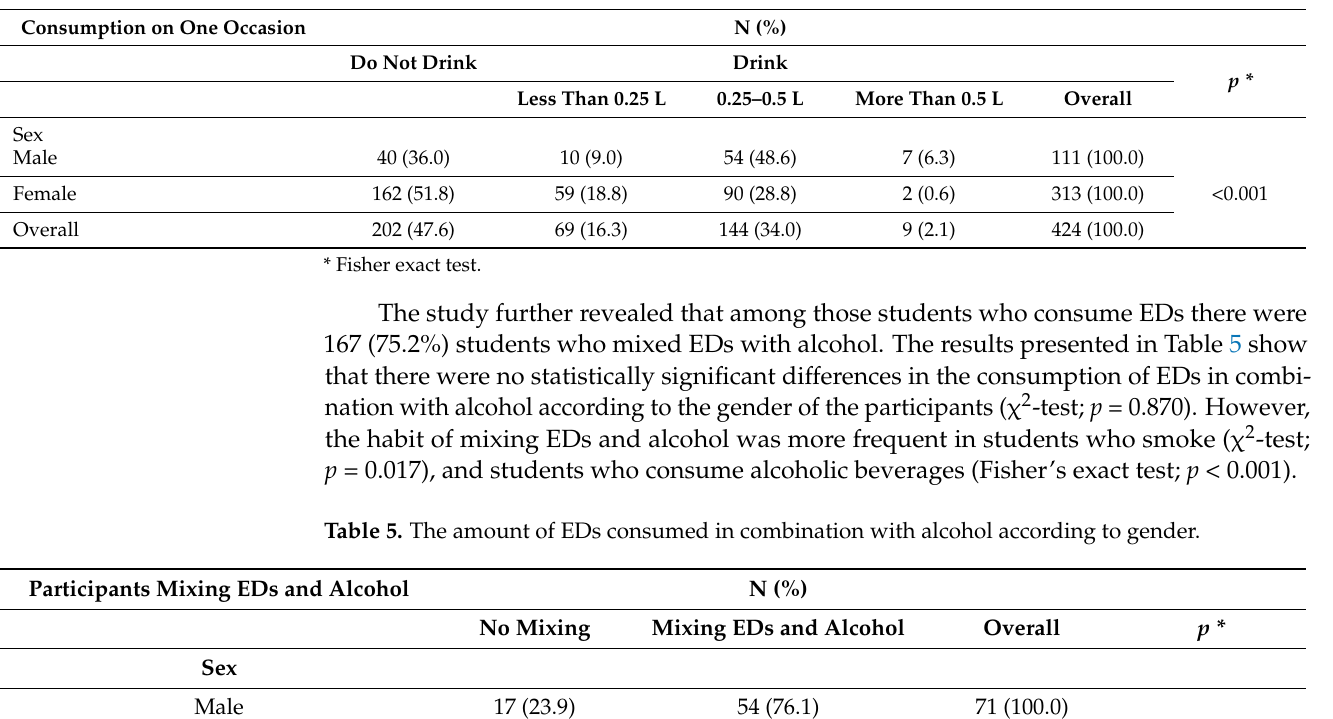
Table 4. The amount of consumed EDs on one occasion according to gender.